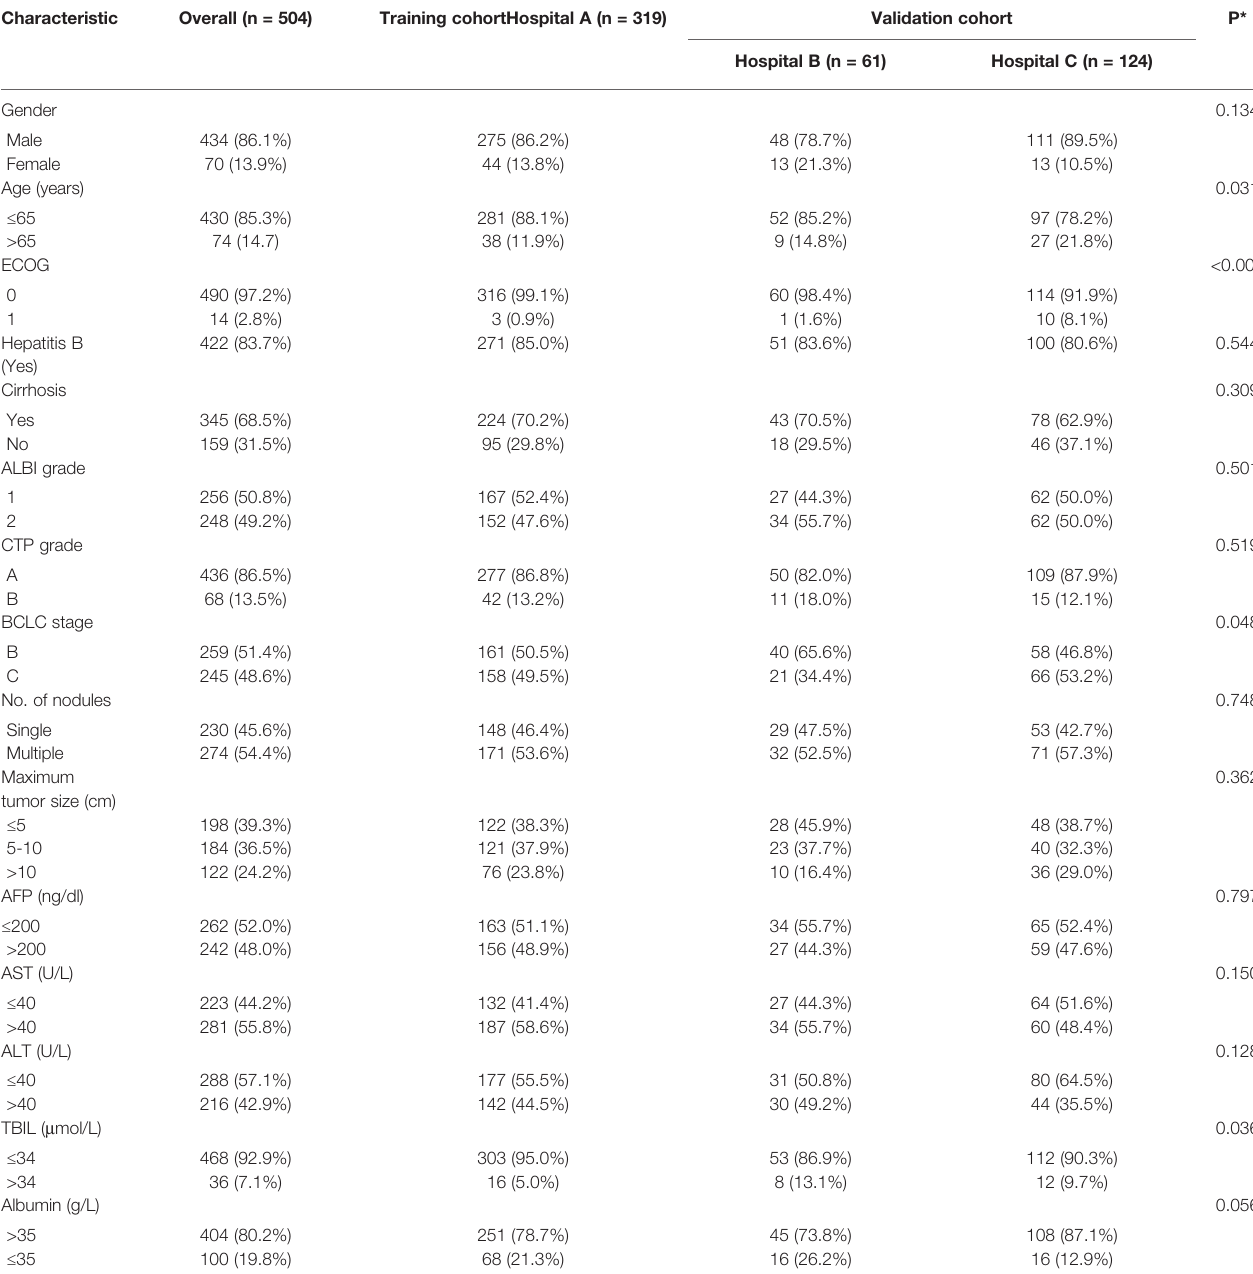
TABLE 1 | Patient